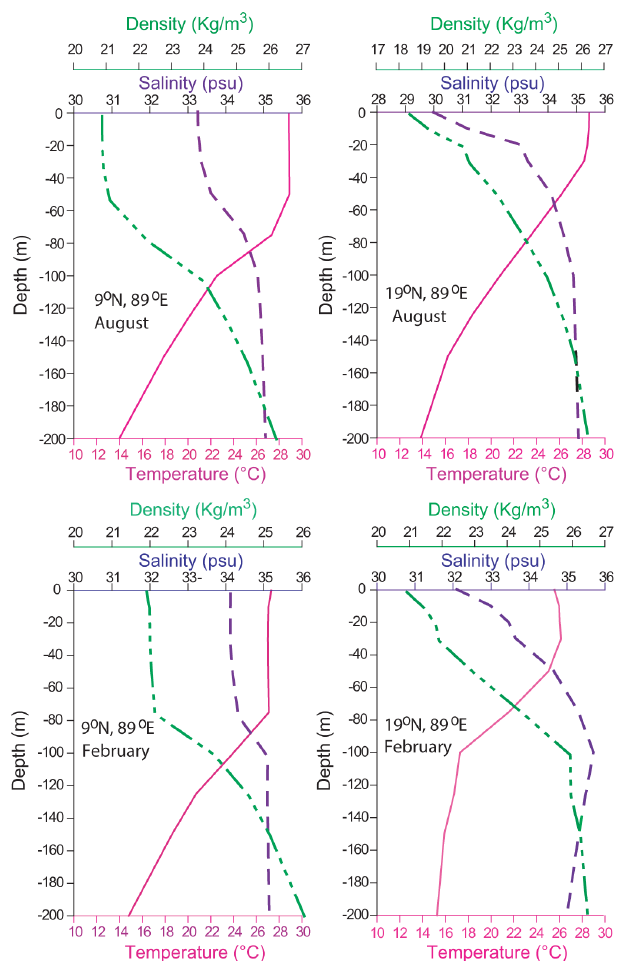
Figure 2. Vertical profiles of temperature, salinity and density (sigma- t ) at two locations representing the northern (19 ◦ N, 89 ◦ E) and southern (9 ◦ N, 89 ◦ E) Bay of Bengal during February (winter) and August (summer).